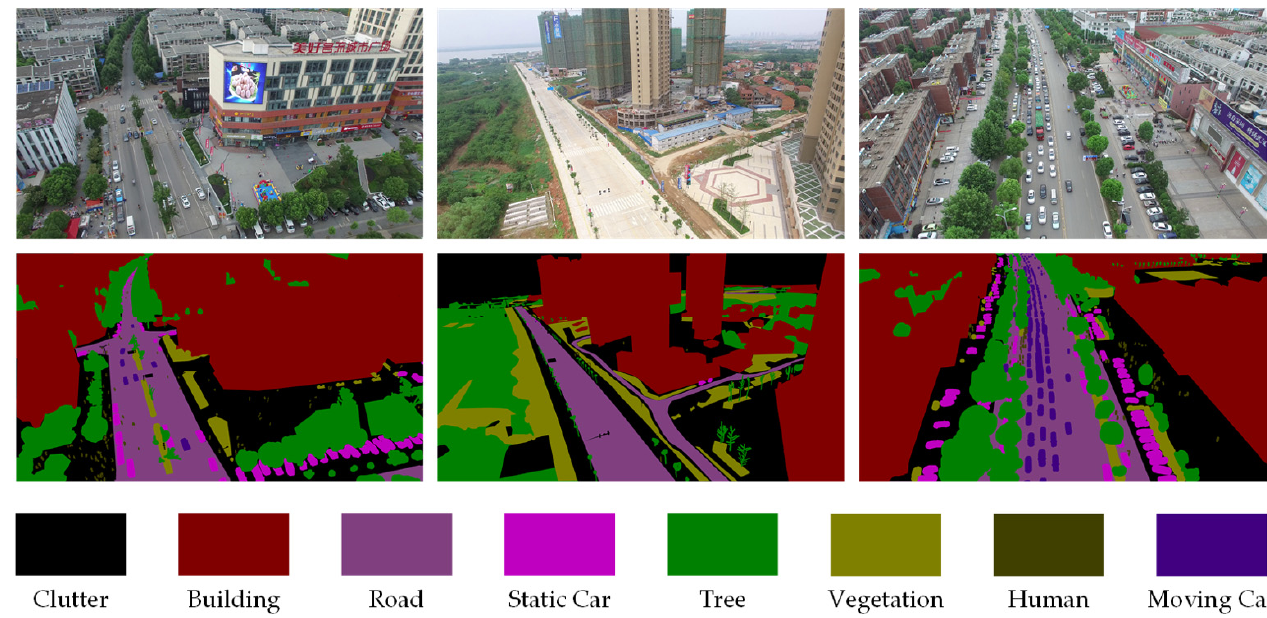
Figure 9. Example images and labels from the UAVid dataset.